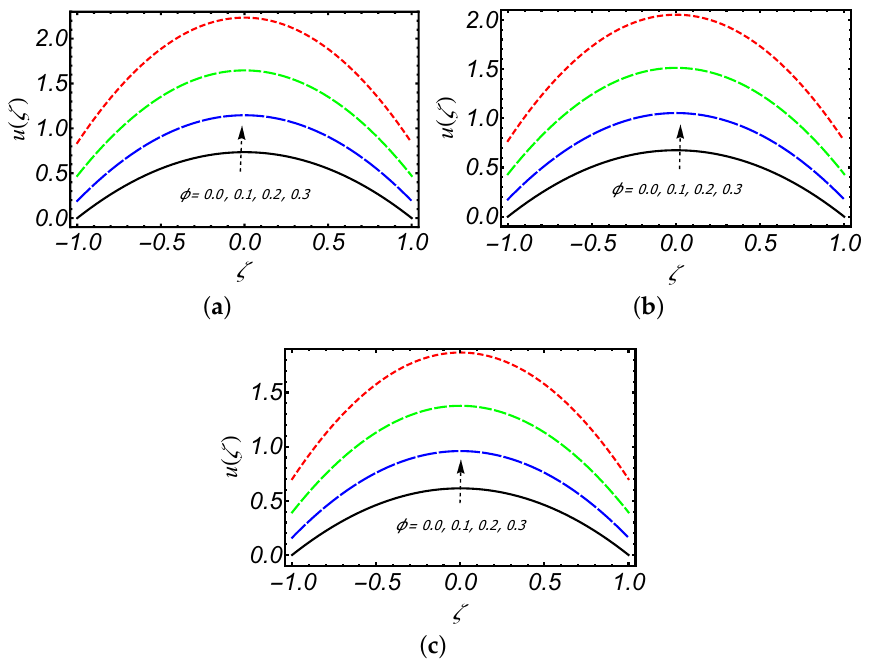
Figure 7. Behavior of u ( ζ ) with φ at ( a ) x = 0.1, ( b ) x = 0.5, ( c ) x = 0.9, when K = 0.2, δ =